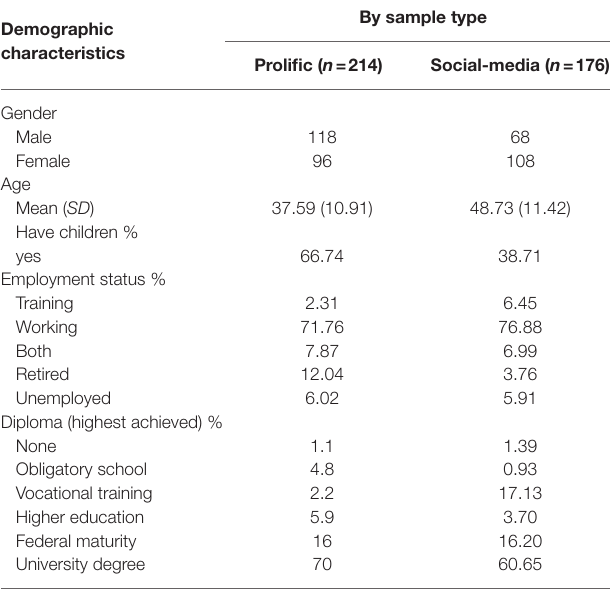
TABLE 2 | Demographic information for social-media and Prolific sample.